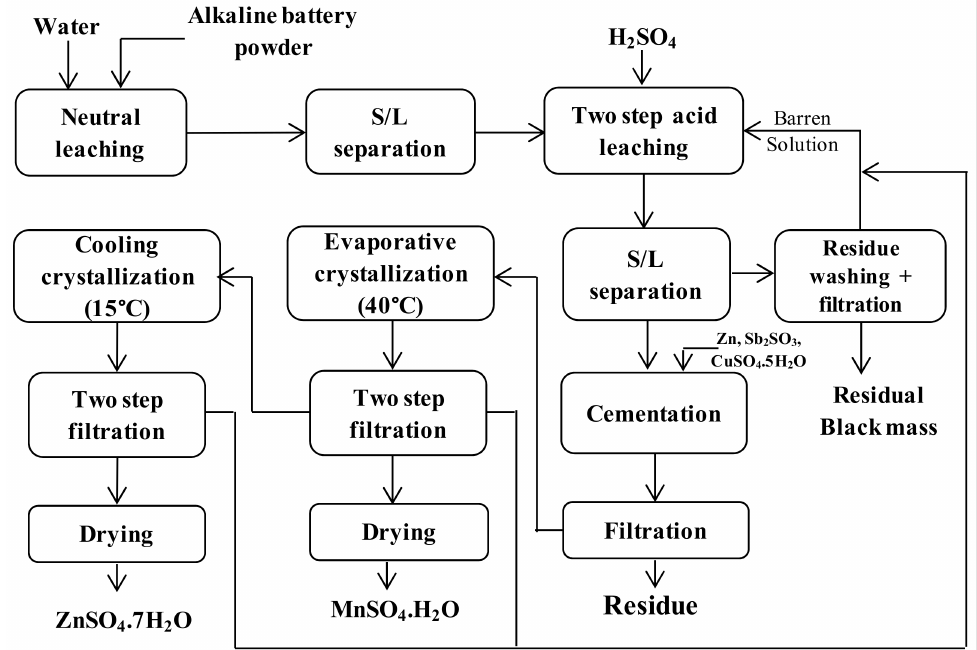
Figure 2. Chemical leaching flow sheet of Zn and Mn extraction from alkaline battery (redrawn and adapted with modifications from